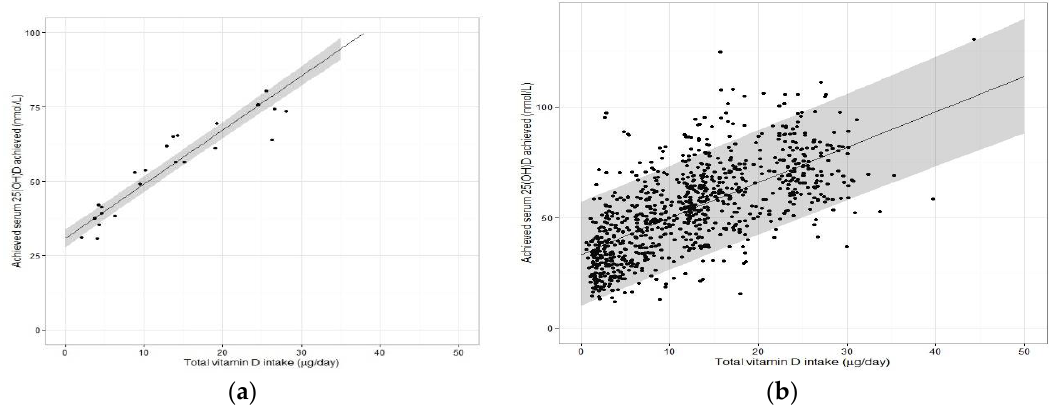
Figure 2. Relationship between total vitamin D intake and achieved serum 25(OH)D in winter time using data from seven randomized controlled trials (RCT) used in our recent individual participant data (IPD) level meta-regression [9]. ( a ) The black dots represent the aggregate RCT group mean data ( n = 23 arms from the collection of 7 RCTs) with associated regression line and 95% confidence intervals around that mean response shown in gray shading. ( b ) The black dots represent the individual data point from each participant from the same 7 RCTs ( n = 882 individuals) with associated regression line and 95% prediction intervals around that mean response shown in gray shading.